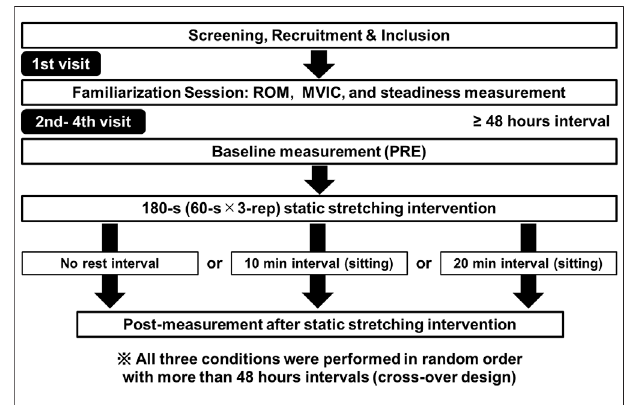
FIGURE 1 | | Experimental protocol. The participants visited the laboratory on four occasions (familiarization session and three experimental sessions, i.e., immediately after (no rest interval), 10-min interval, and 20-min interval after the static stretching intervention). The three experimental sessions were performed in random order with more than 48-h intervals (crossover